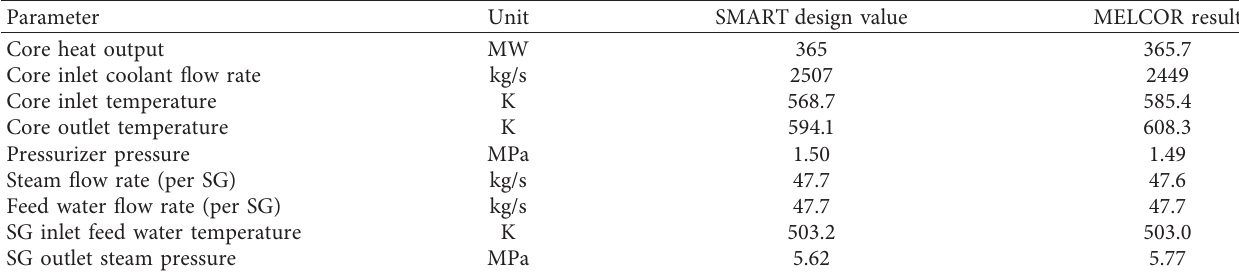
Table 2: Comparison of the SMART operating conditions and MELCOR